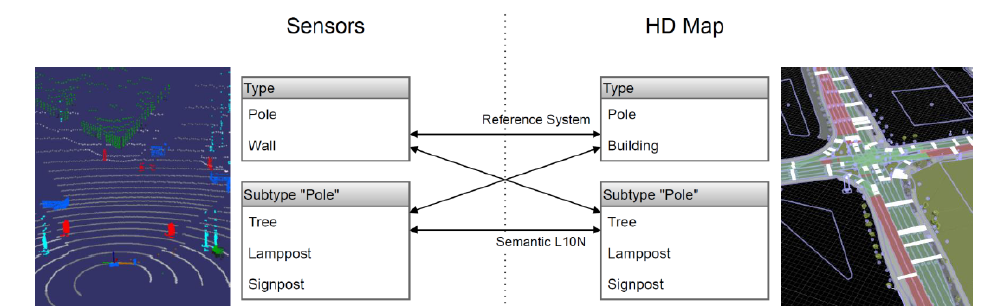
Figure 3. Matching patterns for sensor and map landmarks. Upper level: only geometrical informa- tion; lower level: additional semantic class information (e.g., from camera images). The layered model also enables map matches between different levels of detail on the sensor and map side represented by the diagonal arrows. One possibility is a localization system with semantic information matching against an HD map with only geometric landmark representations. The other possibility is a LiDAR-only localization system using an HD map with extended landmark types. If the sensor system lacks cameras and no classification is performed, a detected “Pole”-type landmark without semantic classification can either be matched to a “Tree” or a “Sign post” subtype marked in the map.